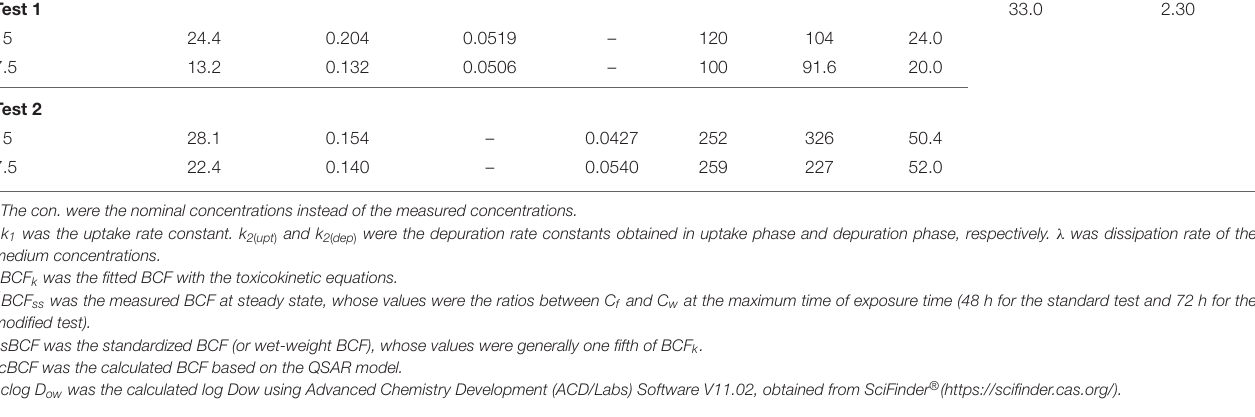
TABLE 2 | Toxicokinetic parameters and BCF values of emodin obtained from zebrafish eleutheroembryos. con. a